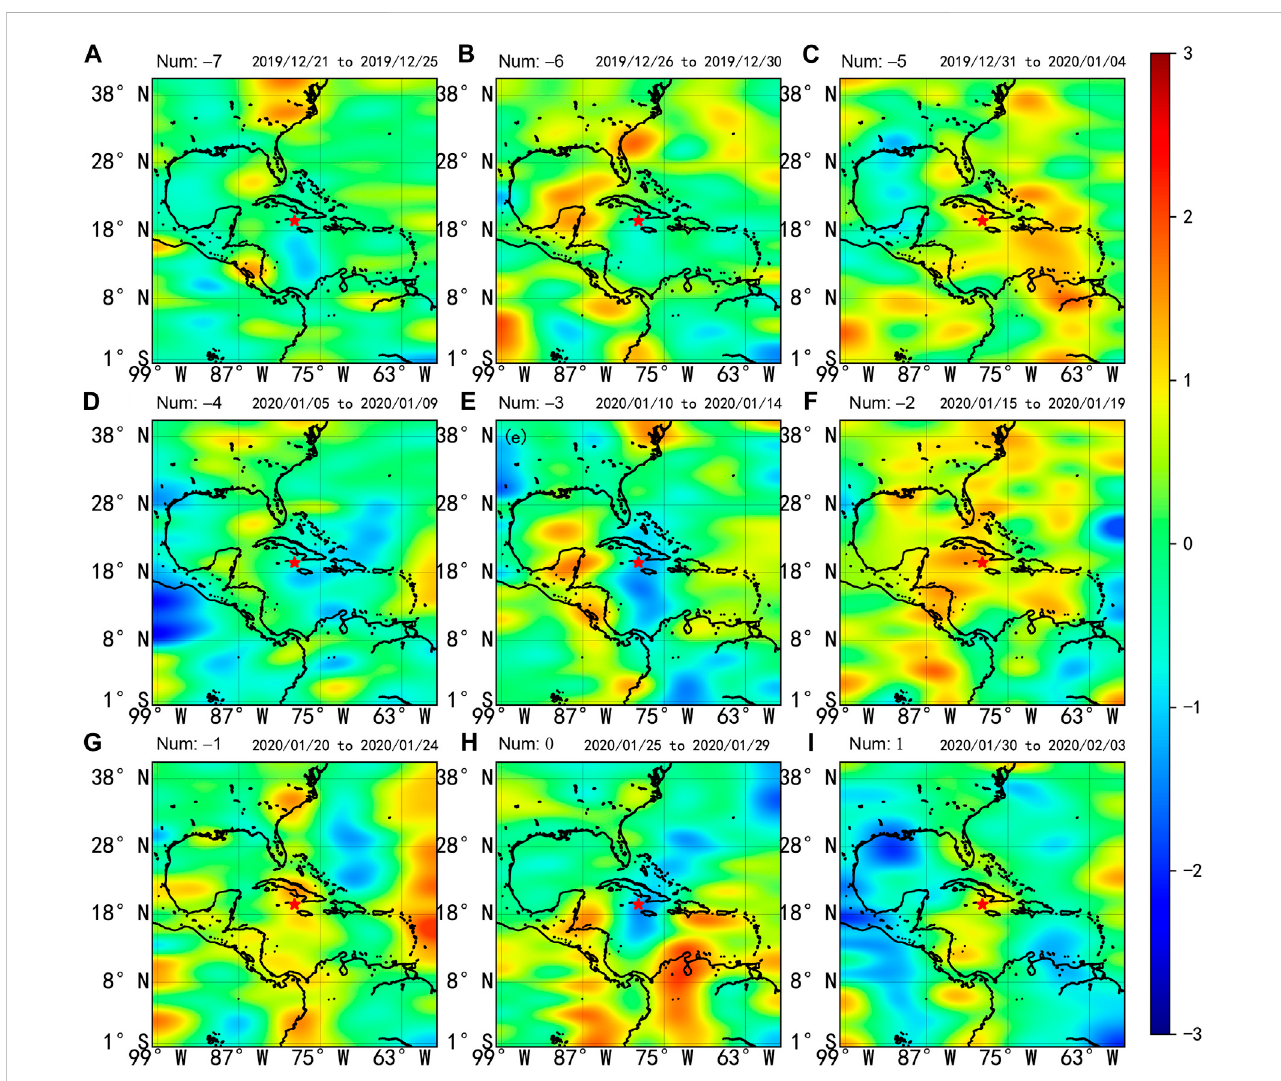
FIGURE 2 Spatialandtemporal evolutioncharacteristicsoftheta valuesbeforeandafterthe2020earthquake inthesouthernwatersofCuba.(Num: − 7toNum: − 1 represents theseventh cycleto the fi rstcyclebefore theearthquake, Num:0istheperiodof earthquake, Num:0isthe fi rstperiodafter theearthquake.Num: − 7 to Num: 2 corresponds to (A – I)